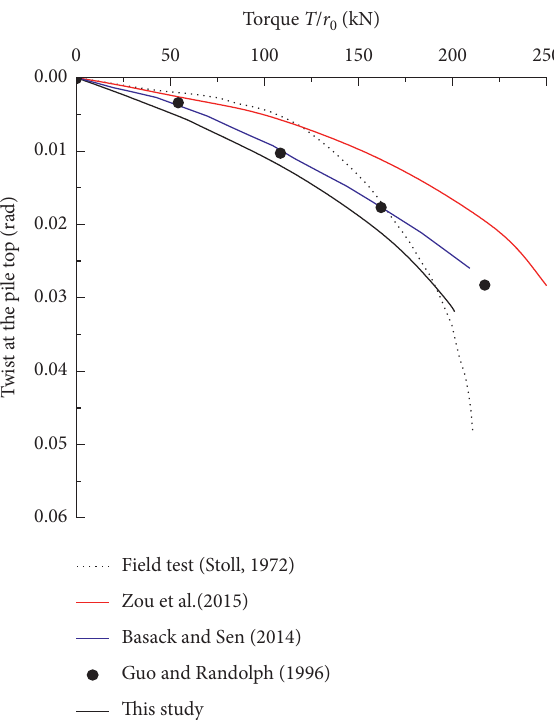
Figure 6: Comparison of the torsion and pile top torsion angle of a single